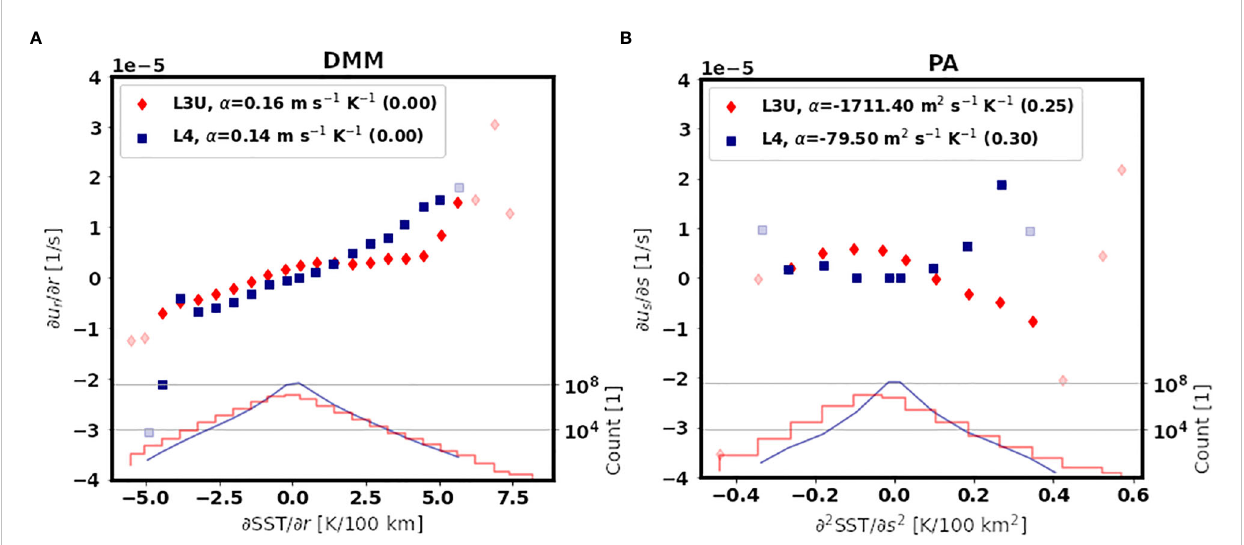
FIGURE 9 Binned scatter plots of (A) along-wind SST gradient ( ∂ SST/ ∂ r) and along-wind wind divergence ( ∂ ur/ ∂ r) , and (B) across-wind SST Laplacian ( ∂ 2 SST/ ∂ s 2 ) and across-wind wind divergence ( ∂ us/ ∂ s). Transparent symbols indicate that less than 100 values were considered in the corresponding bin. In the lower part of the fi gure, the histogram of the forcing SST fi elds are shown. The legend contains the linear regression slope of the scatter plots denoted as a and its p-value in